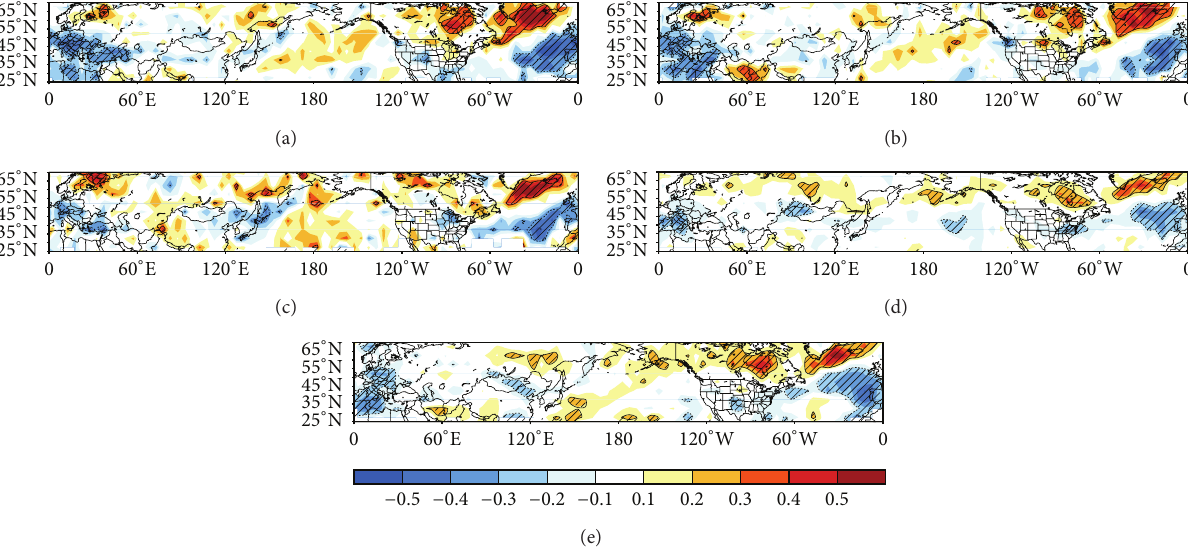
Unlike the IOD, NAO-induced storm tracks show a similar pattern for all datasets, with positive correlations south of Greenland and negative correlations across the mid- latitude North Atlantic eastward across Europe (Figure